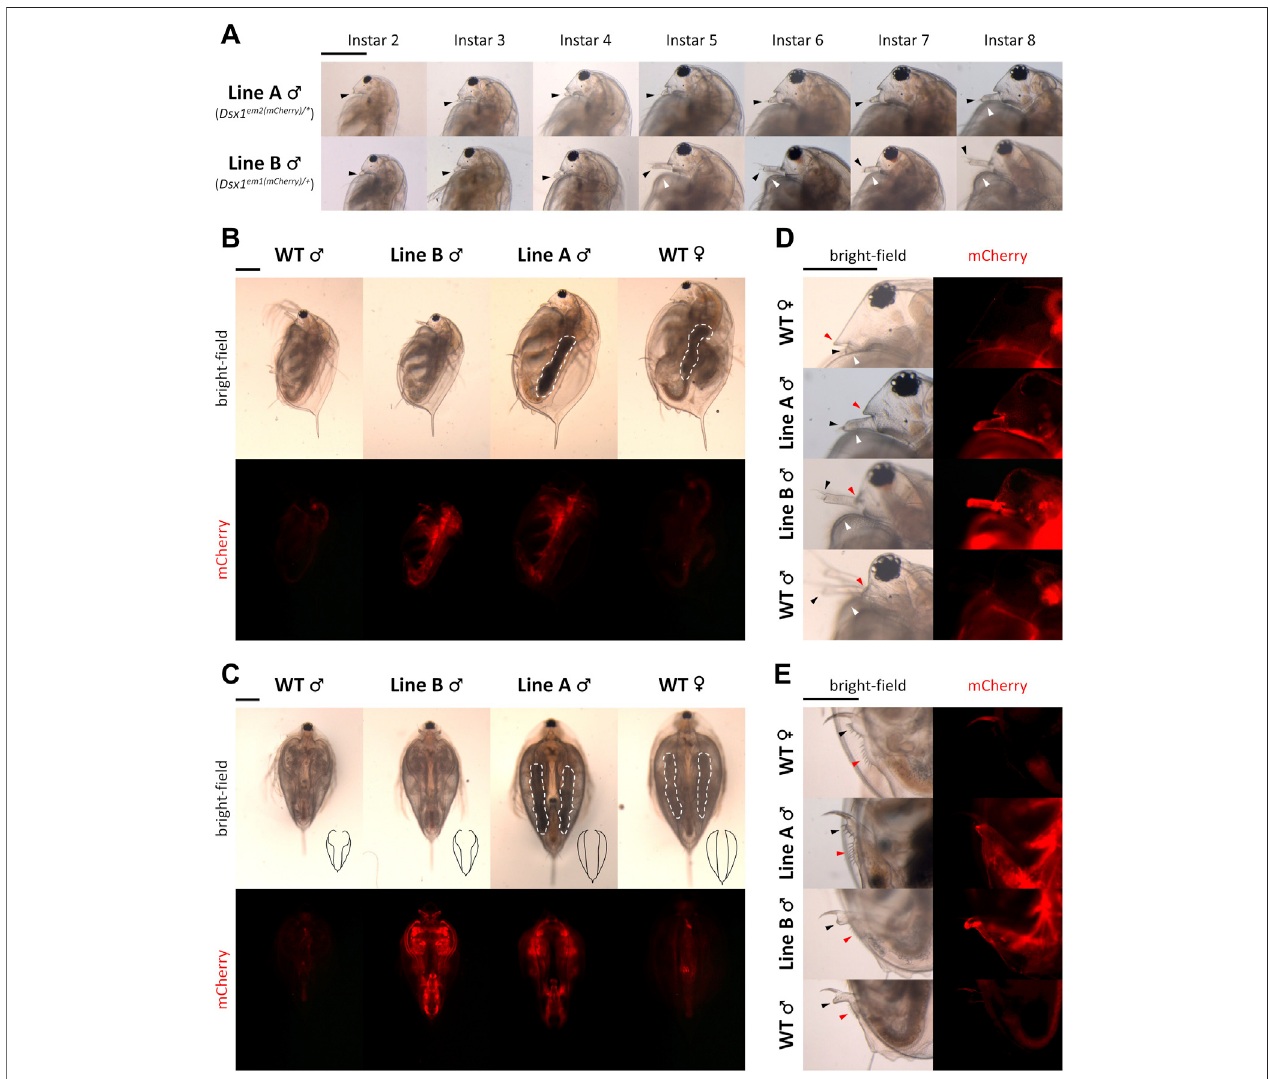
FIGURE9| Feminizationinthephenotypeof Dsx1 mutants.Headregionwithafocusonthe fi rstpairofantennaeofLineAmalesandLineBmalesofvariousages. Untilinstar4,juvenilestagesofdaphniidscontinue. Transitiontofullymatureadultsusuallyoccurswhentheanimalreachesinstar5,whichisapproximately 1 weekafter birth. Black-arrowheads: fi rst antennae. White arrowheads: carapace curve that reveals copulation hooks in males. (B) Full body, side view of instar 8 daphniids. White dotted lines indicate ovary-like gonads, which appeared darker because of the accumulation of yolk protein. (C) Full body, ventral view of instar 8 daphniids. Black drawingsatthebottomrightcornerofeachbright- fi eldphotoaretracinglinesscaleddowntoa1:2.26ratiodepictingtheoutlineofthecarapaceedge.Whitedottedlines have the same meaning as in panel (B) . (D) Head region, side view of instar 8 daphniids. Black and white arrowheads have the same meaning as in panel (A) . Red arrowheads indicate the rostrum. (E) Genital and anal region, side view of instar 8 daphniids. Black arrowheads: genital. Red arrowheads: anus. Each panel from (A – E) has one scale bar indicating 0.5 mm, which is shared among all photos of the same panel. Adapted from Nong et al. (2020).